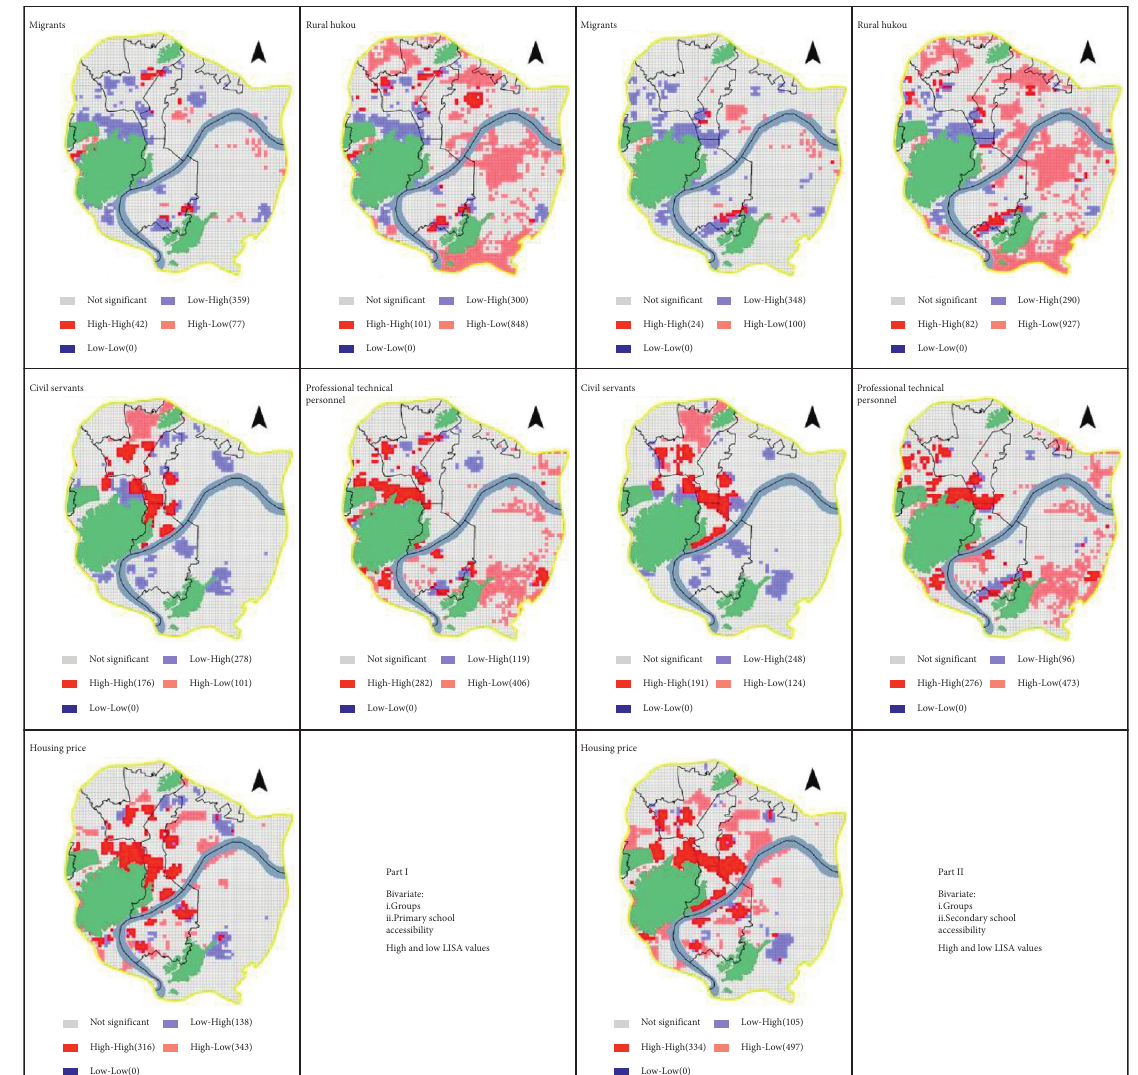
Figure 4: LISA high and low cluster of education accessibility among different